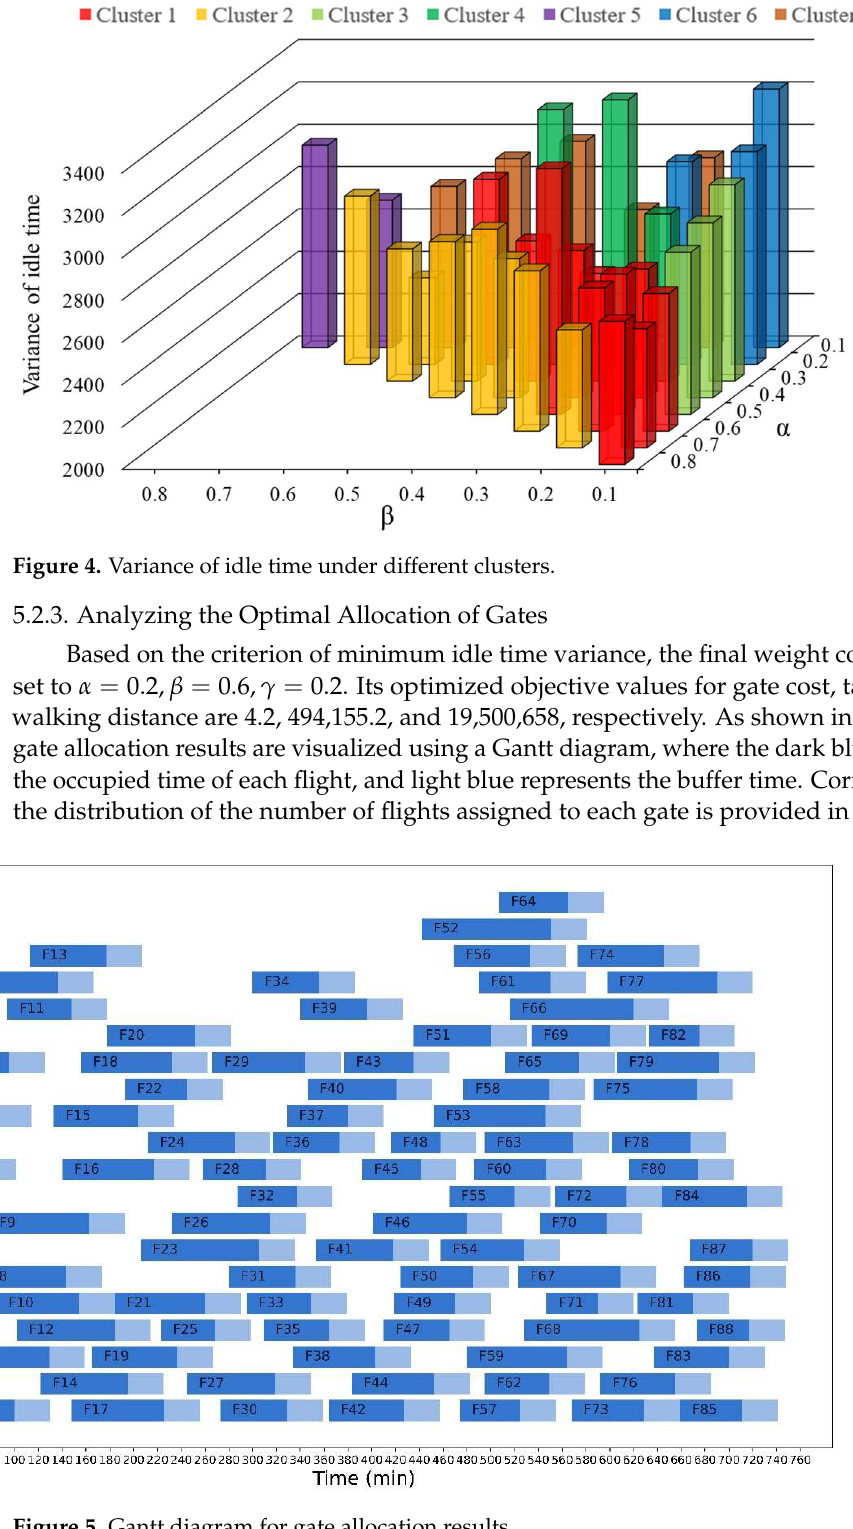
Figure 6. Number of flights allocated for each gate. Overall, all gates are fully utilized and there are no idle gates during the entire time period. Although remote gates have the highest cost in terms of walking distance, taxi time, and gate size, they still cannot avoid being used. In our final results, each of the two remote gates (i.e., G19 and G20) served one flight. As mentioned earlier, during the time period of 15:00–18:00, a large number of flights were piled up, resulting in all contact gates being occupied. This phenomenon can be clearly seen from Figure 5. Additionally, among all contact gates, G1 has the most flights allocated, with a total of seven flights. This is because it has absolute advantages in taxi time and walking distance among small-size gates. In contrast, G16 and G18 are allocated the fewest flights due to their larger taxi time and the larger proportion of taxi cost in this weight combination. In addition, we also counted the relative utilization rate and absolute utilization rate of each gate, as shown in Figure 7. On the whole, the utilization rate of the contact gate is relatively high, except for the remote gate. Additionally, the absolute utilization rate of most of them is above 40%, while the relative utilization rate is above 55%. Similar to the